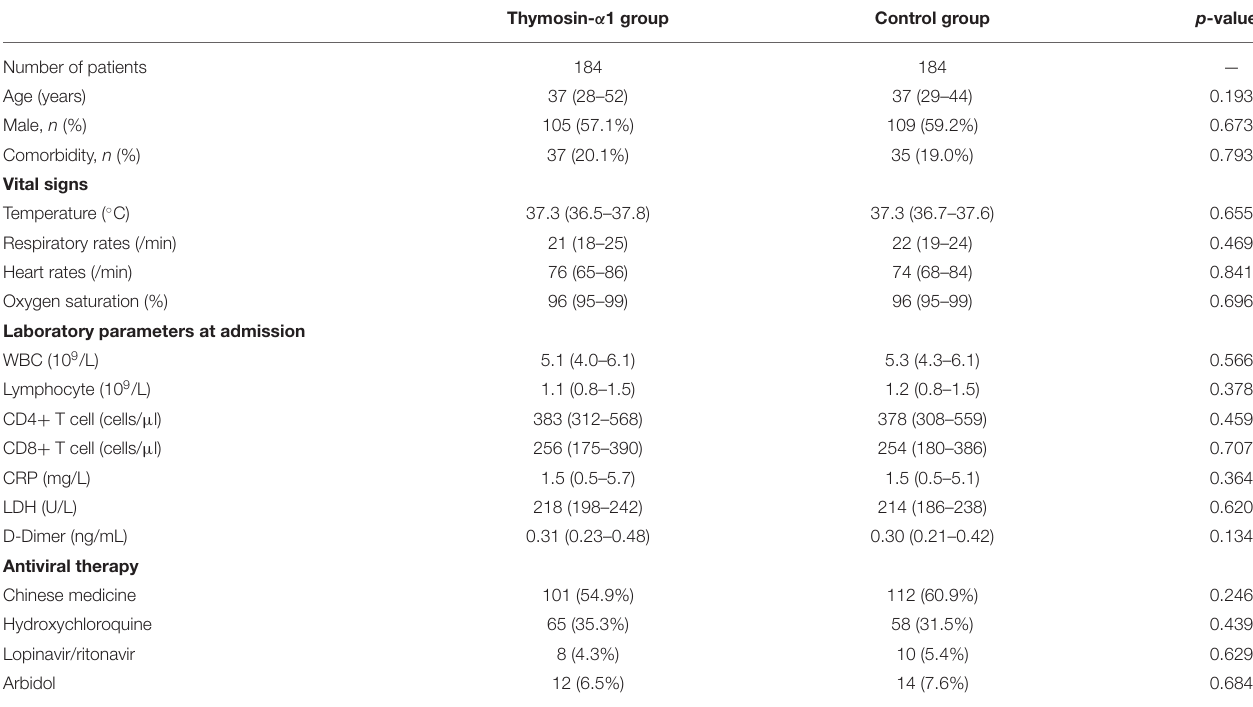
TABLE 3 | Baseline characteristics of patients after propensity score matching.